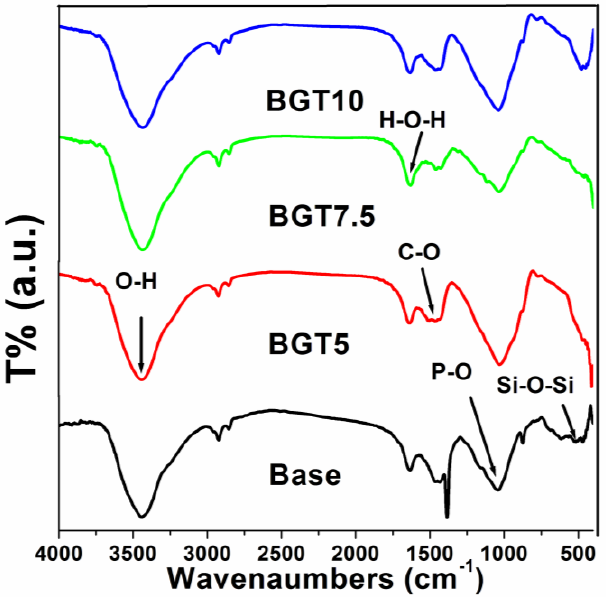
Figure 3. Fourier-transform infrared spectroscopy spectra of the prepared glass doped with TiO 2 .